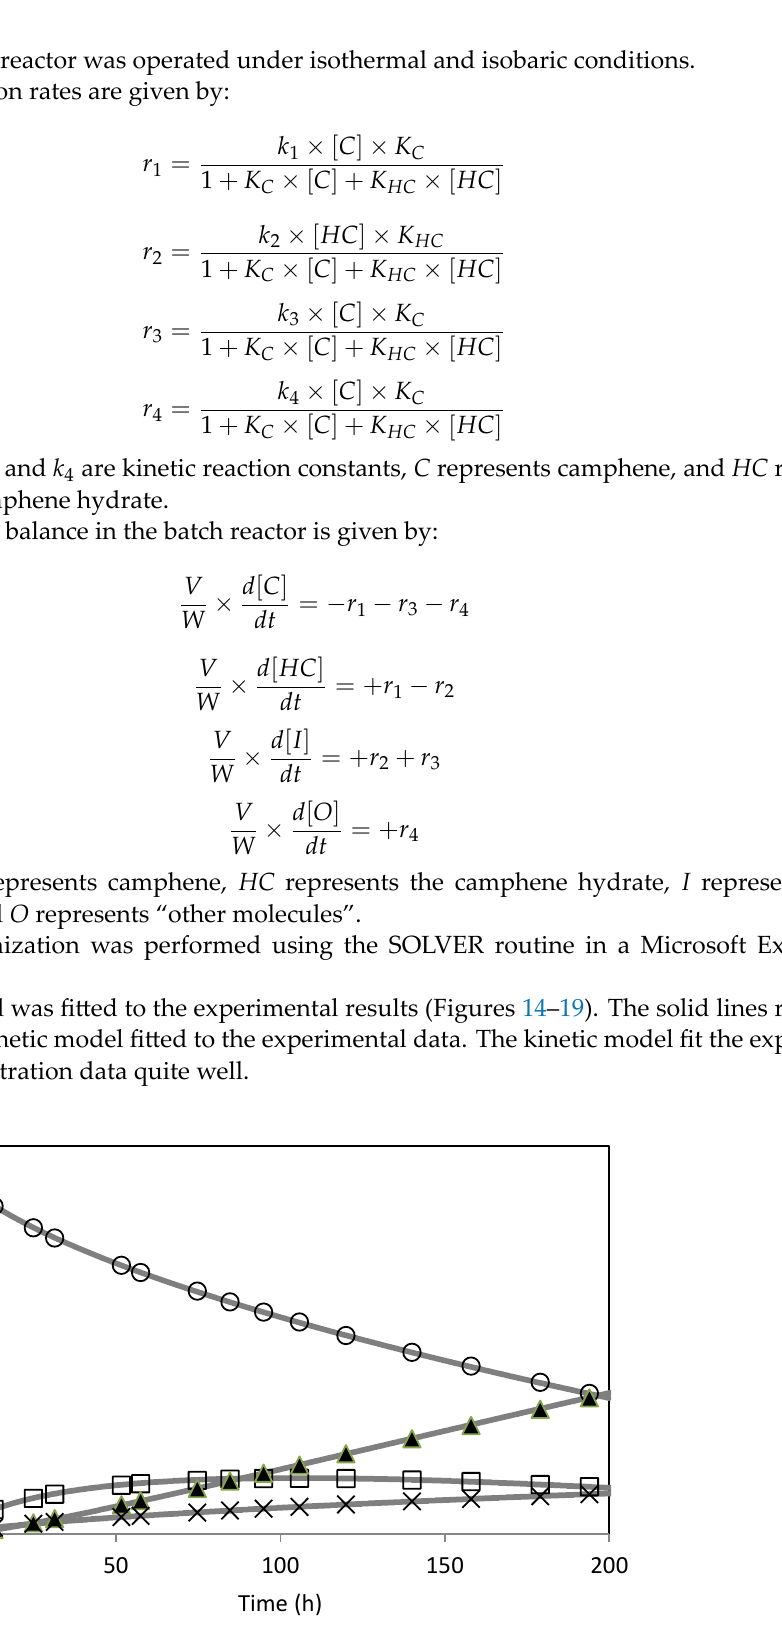
Figure 14. Camphene hydration over SBA‑15‑SO 3 H catalyst. ( # ) Camphene; ( □ ) Camphene hydrate; ( ▲ ) Isoborneol; ( × ) Others. The lines represent the model fitted to the experimental points.